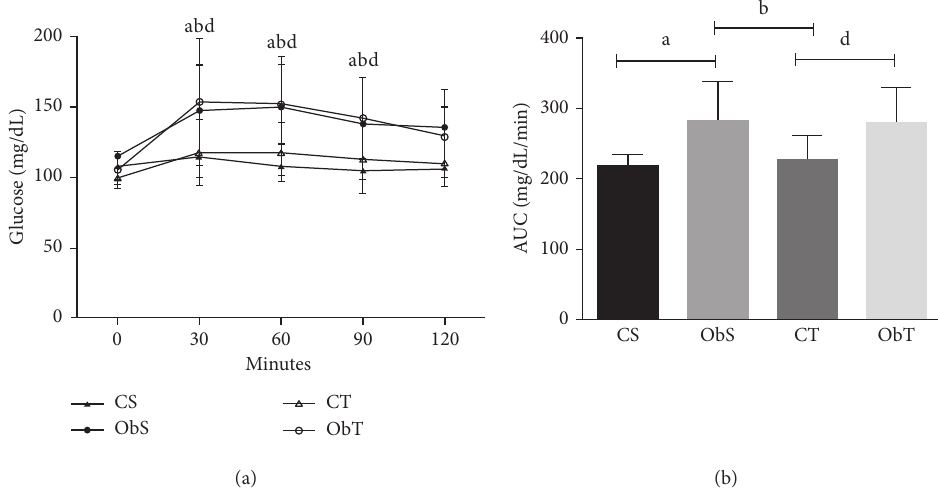
Figure 5: Data expressed as mean ± standard deviation. CS � sedentary control ( n � 10); CT � control submitted to the strength training protocol ( n � 10); ObS � sedentary obese ( n � 7); ObT � obese submitted to strength training protocol ( n � 9). p < 0 . 05: a ObS vs. CS; b ObS vs. CT; d ObT vs. CT. Two-way ANOVA supplemented with the Bonferroni post hoc test for normal distribution